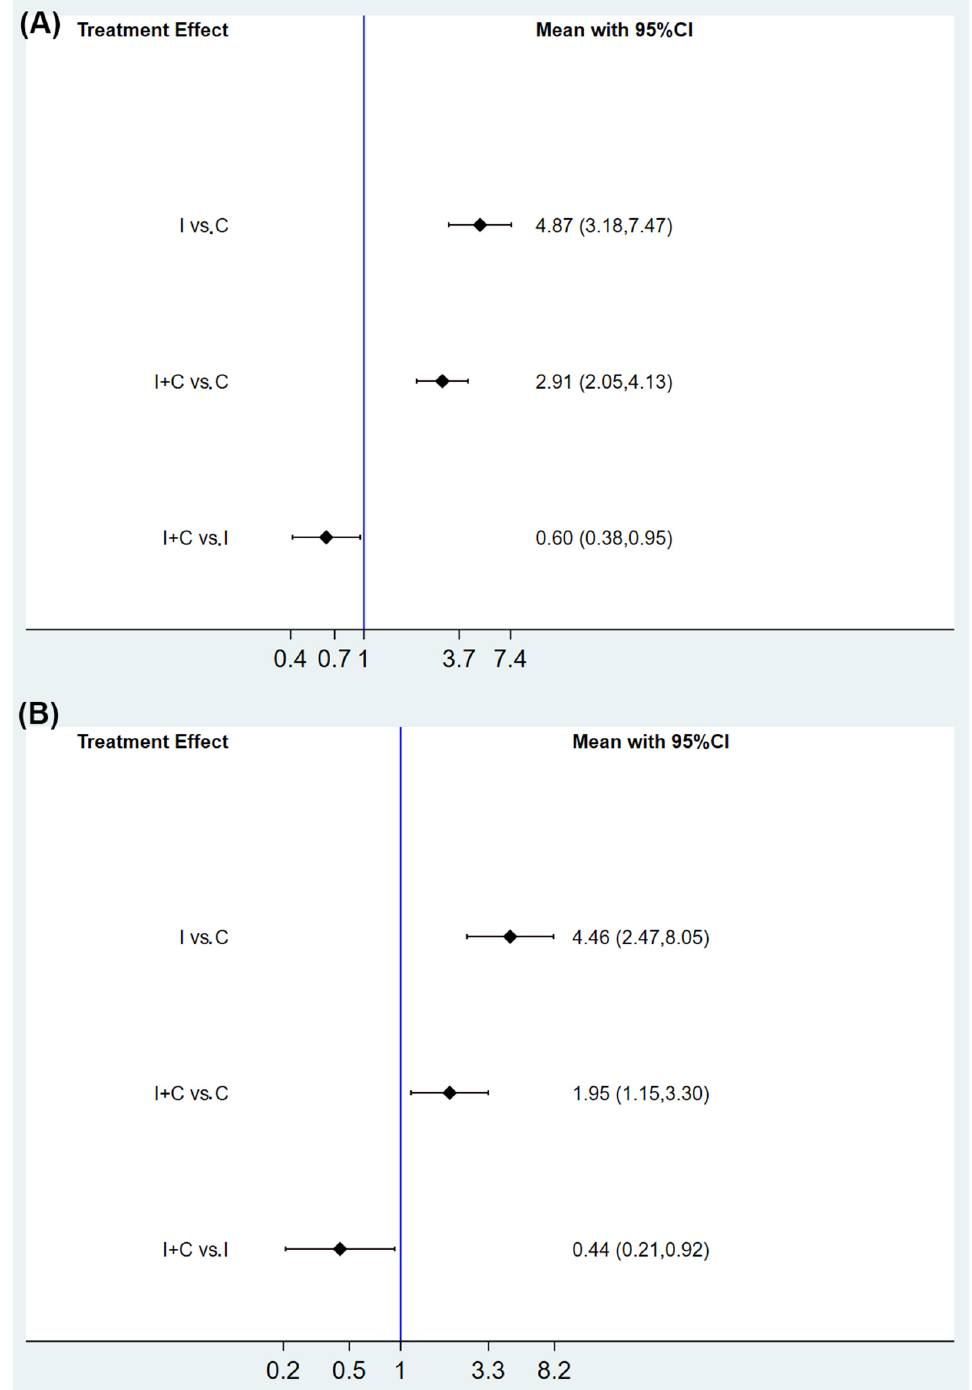
( B ) in the overall population, based on the consistency model. IRP, immune-related pneumonitis; Figure 4. Comparative different treatments for the risk of any grade IRP ( A ) and grade 3–5 IRPs ( B ) I+C group, PD-1/L1 inhibitors plus chemotherapy; I group, PD-1/L1 inhibitors monotherapy; C in the overall population, based on the consistency model. IRP, immune ‐ related pneumonitis; I+C group, PD ‐ 1/L1 inhibitors plus chemotherapy; I group, PD ‐ 1/L1 inhibitors monotherapy; C group, group, chemotherapy.